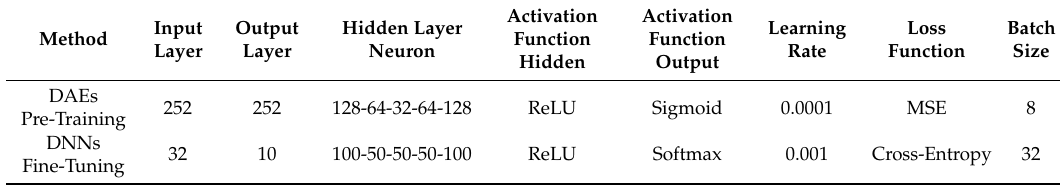
Table 3. The proposed structure of deep learning of model